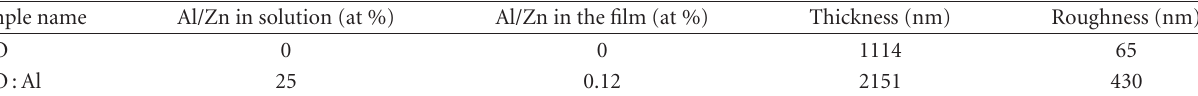
Table 1: Composition of the films and their average thickness and roughness.